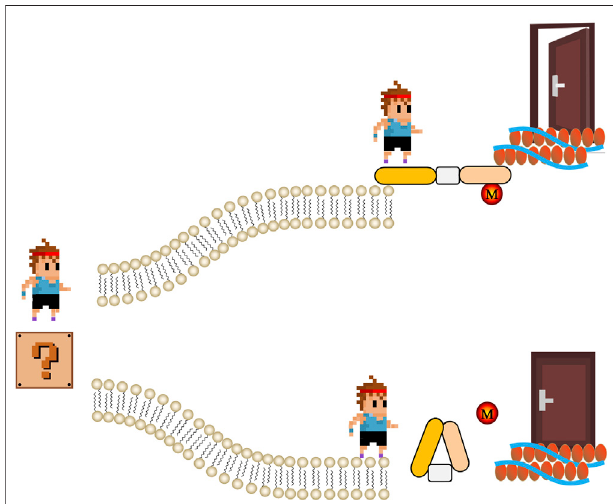
FIGURE 1 | The schematic of regulation of actin-binding proteins by post-translational modi fi cations in signaling. Extracellular signal (represent by a cartoon boy standing in a question mark) meets two roads made by phospholipid bilayer. If actin-binding proteins are active (usually regulated by post-translational modi fi cations, M), signal can go through and get to cytoskeleton. Therefore, the door that representing biological function of extracellular signal is open. On the contrary, if the actin-binding proteins are not active, cartoon boy stops in the other road.